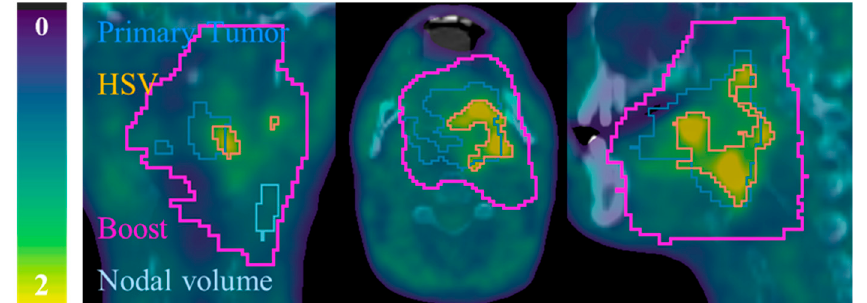
Figure A1. Example of contours for patient P08. 18 F-FMISO-PET/CT slices: coronal (left), axial (middle) and sagittal (right). All 18 F-FMISO -PET images of were represented with a scale (0, 2) g/mL and superimposed to the corresponding CT.